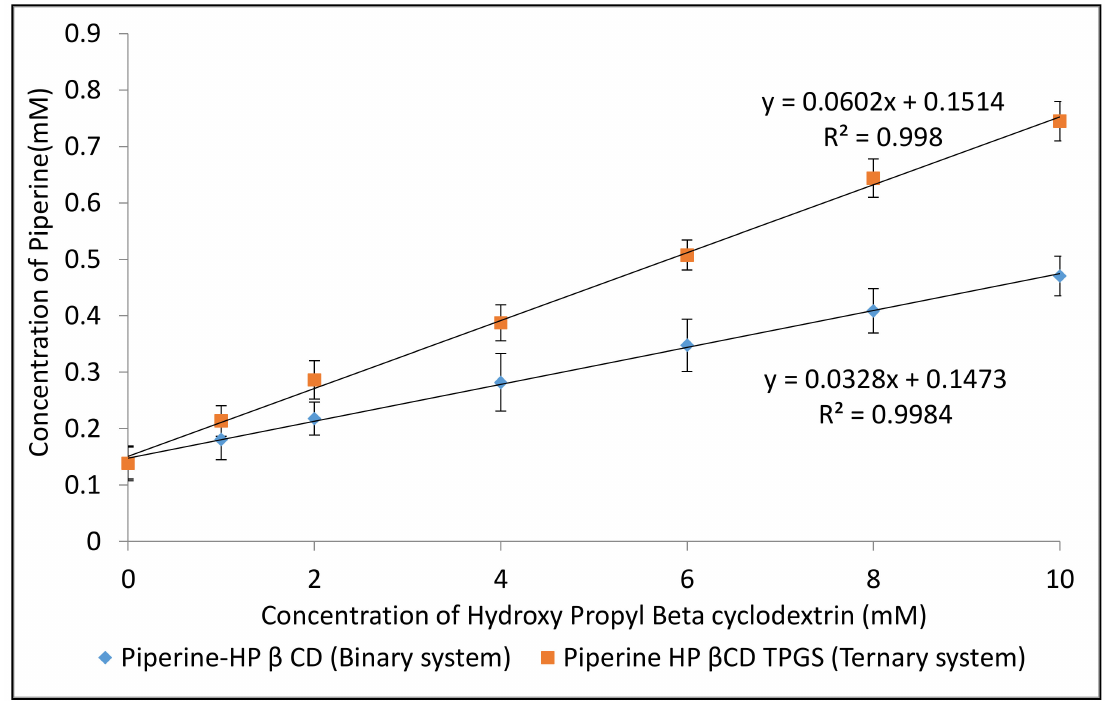
Figure 2. Phase solubility study profile of binary (PIP–HP β CD) and ternary (PIP–HP β CD–TPGS) inclusion complex systems. Values are presented as means ± SD with